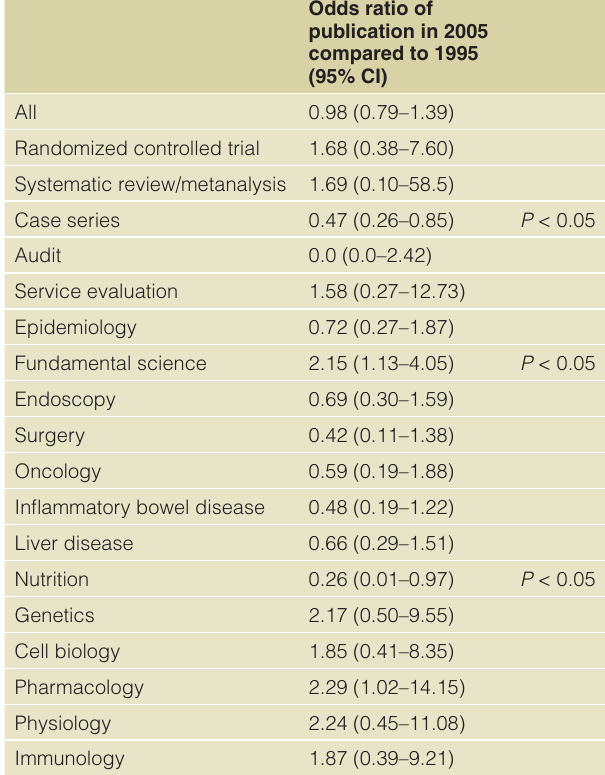
Table 1. Odds ratios with 95% confidence intervals for full publication of abstracts presented in 2005 compared to those presented in